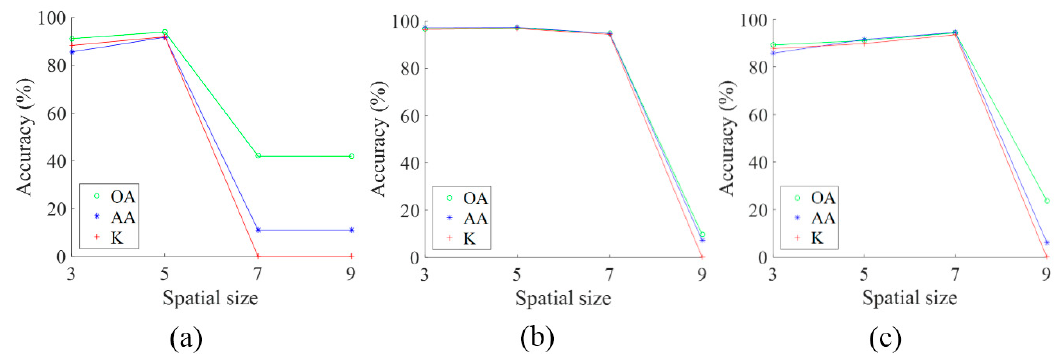
Figure 15. Influence of the spatial size of sample. ( a ) Pavia University scene. ( b ) Botswana scene. ( c ) Indian Pines scene.